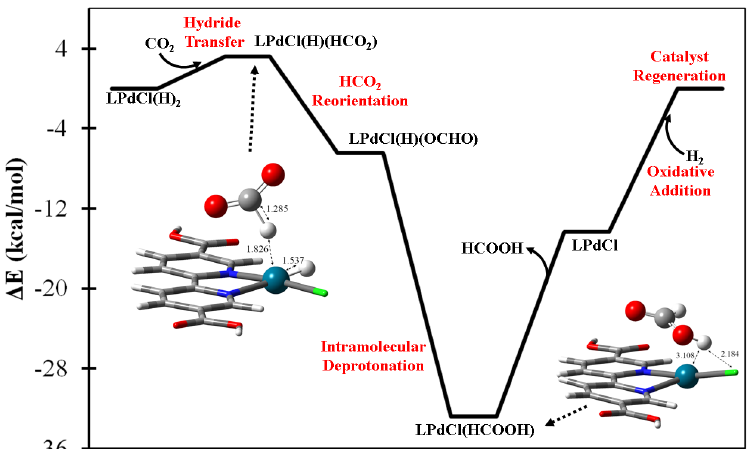
Figure 3. The predicted catalytic mechanism of HCOOH(g) generation by the (bpydc)PdCl(H) 2 complex with H 2 (g) + CO 2 (g).